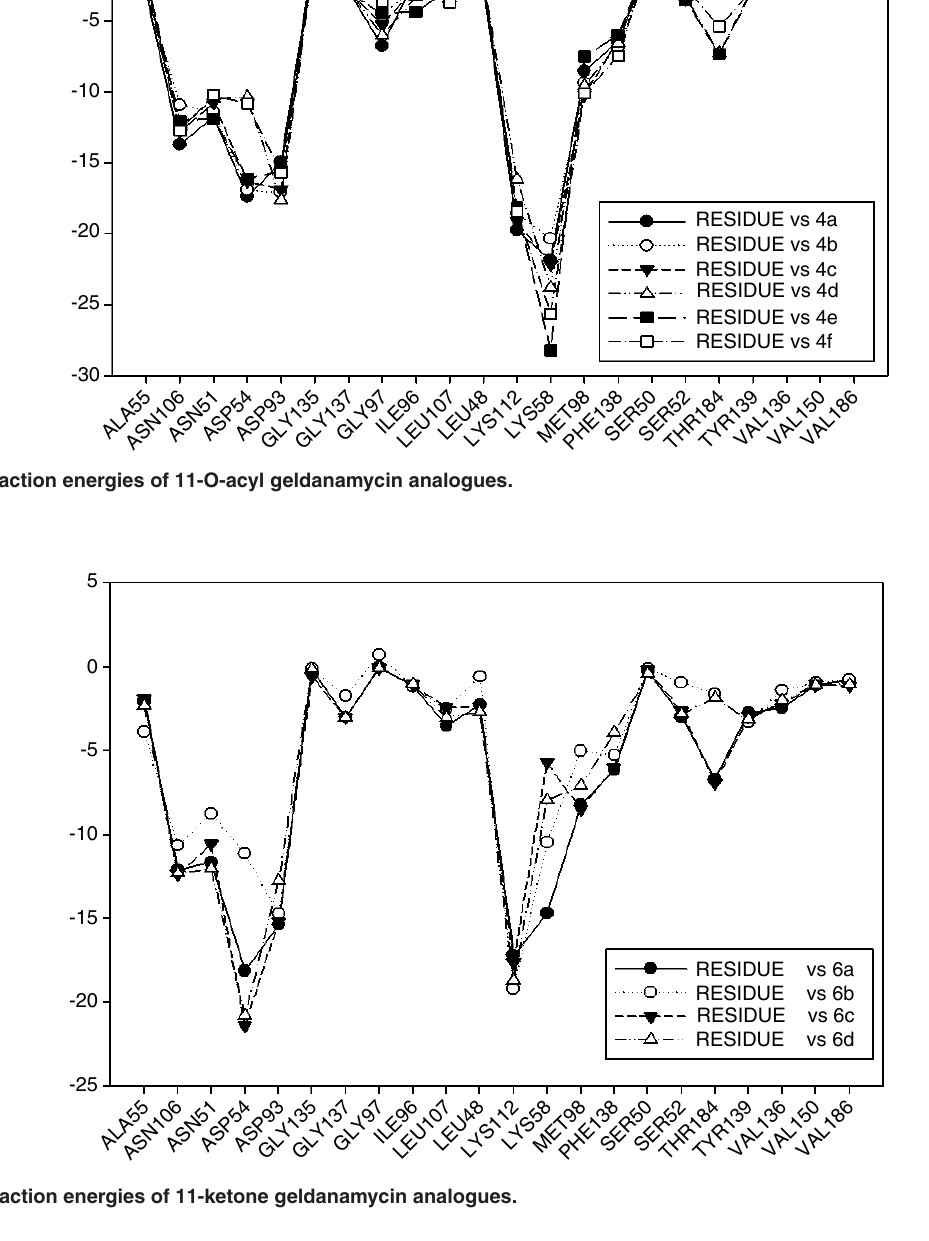
hand, the interaction these analogues have with Asp54 serves to give stability to the complexes, especially for those analogues of geldanamycin possessing a secondary amine on C-17. Figure 15 also plots the values of I.E for 11-oxime analogues of geldanamycin.